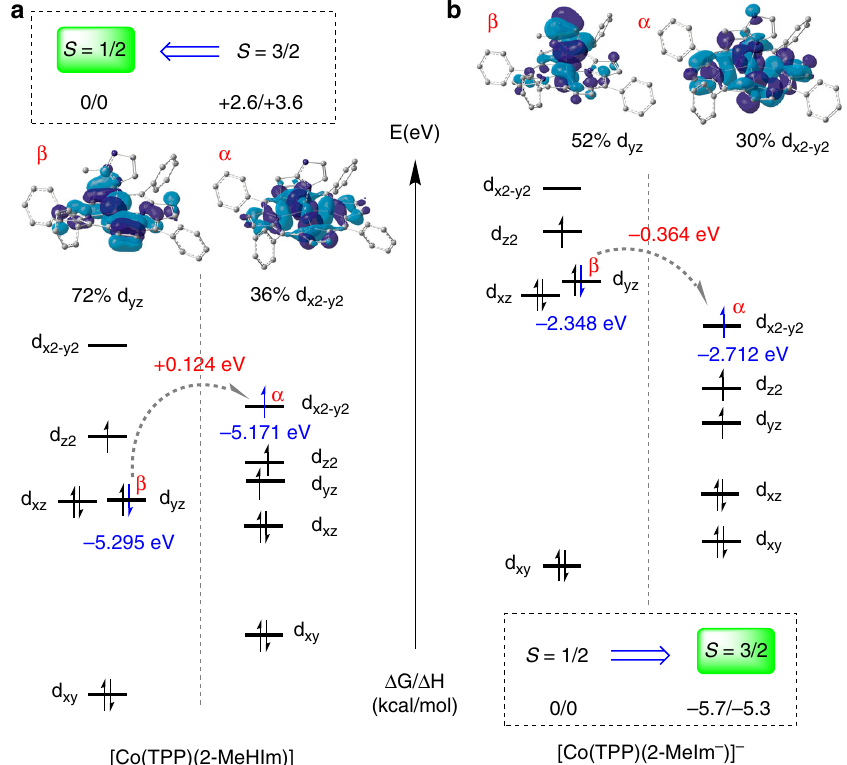
Fig. 5 Qualitative diagrams showing the d-orbital energy ordering. a [Co(TPP)(2-MeHIm)] and b [Co(TPP)(2-MeHIm − )] − ; iso-value =